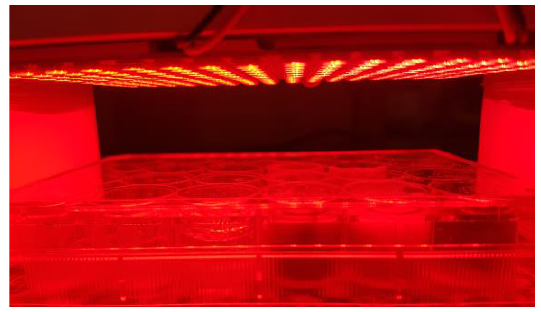
Figure 2. Illumination of EOChl-0.5 gels.